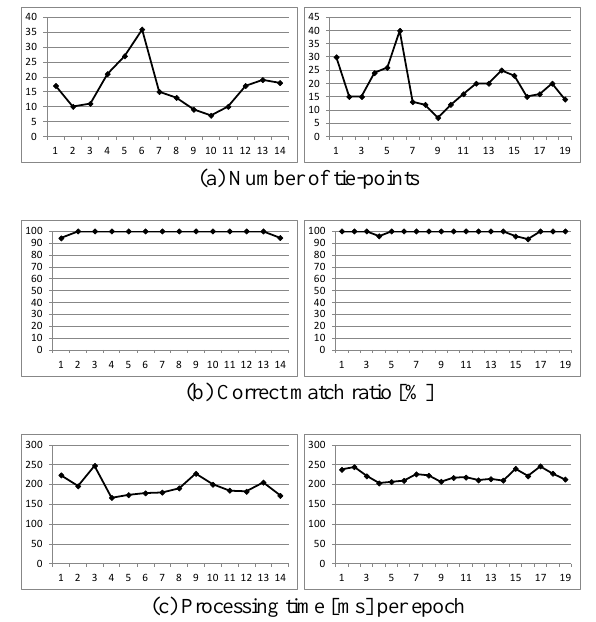
Figure 4. The results of the first experiment are presented on the left and the second experiment on the